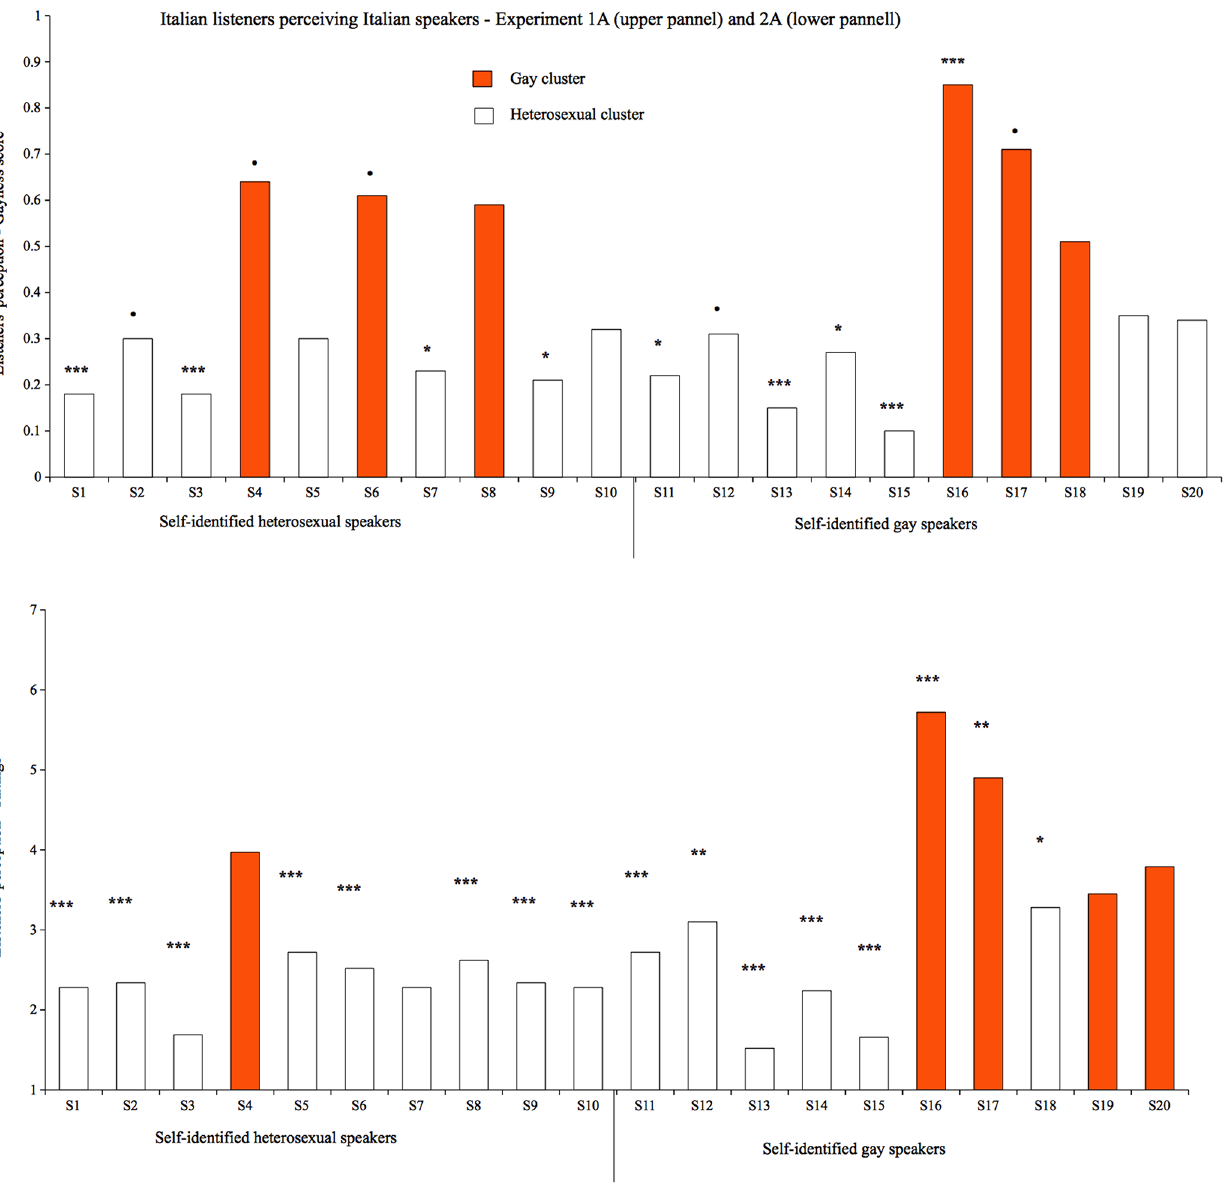
Fig 2. Italian listeners & Italian speakers. Listeners ’ perception in terms of gayness score (2A) and ratings (2B). Different colors indicate the two clusters based on listeners' perception. Stars (and points) indicate speakers that were significantly perceived either as heterosexual or gay (. < .1; * < .05; ** < .01; *** < .001). Higher values of the y-axis indicate perceived gayity, lower values perceived heterosexuality; .5 represents chance